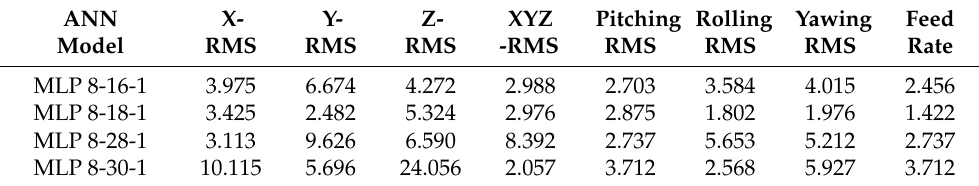
Table 6. Sensitivity levels of the input